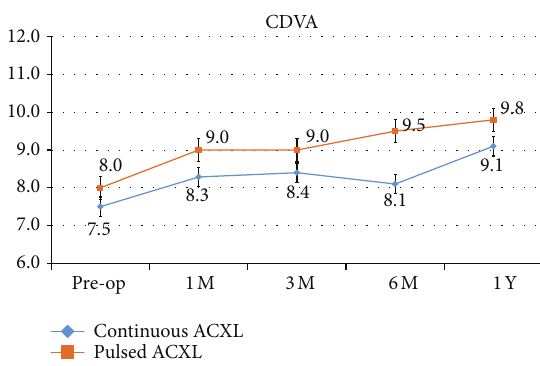
Figure 2: Corrected distance visual acuity (CDVA) after continuous light (blue line) and pulsed light (orange line) accelerated crosslink- ing gained +1.6 and 1.8 decimal equivalents on average, respectively, one year after treatment.